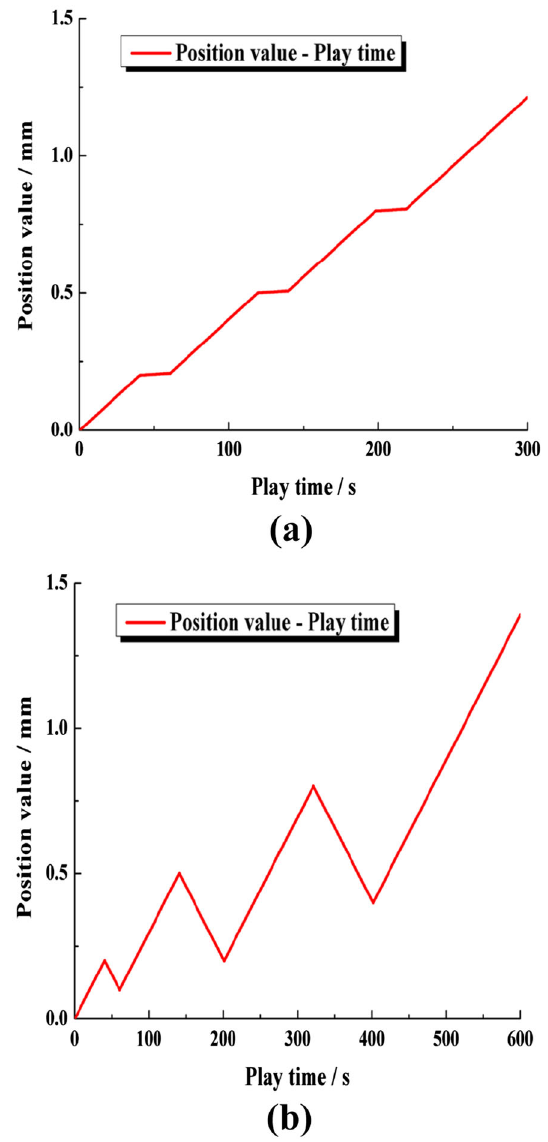
Fig. 5 The loading paths of program setting. a . Grade loading, b . Cyclic